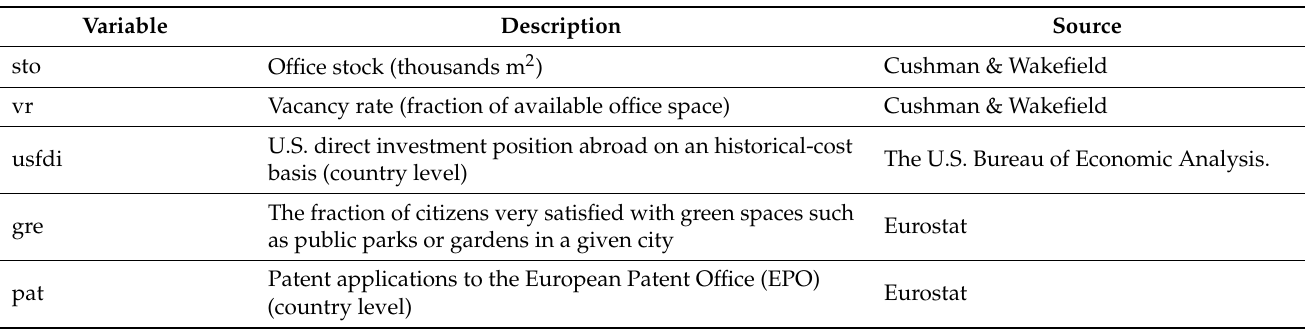
Table 1. Explanatory